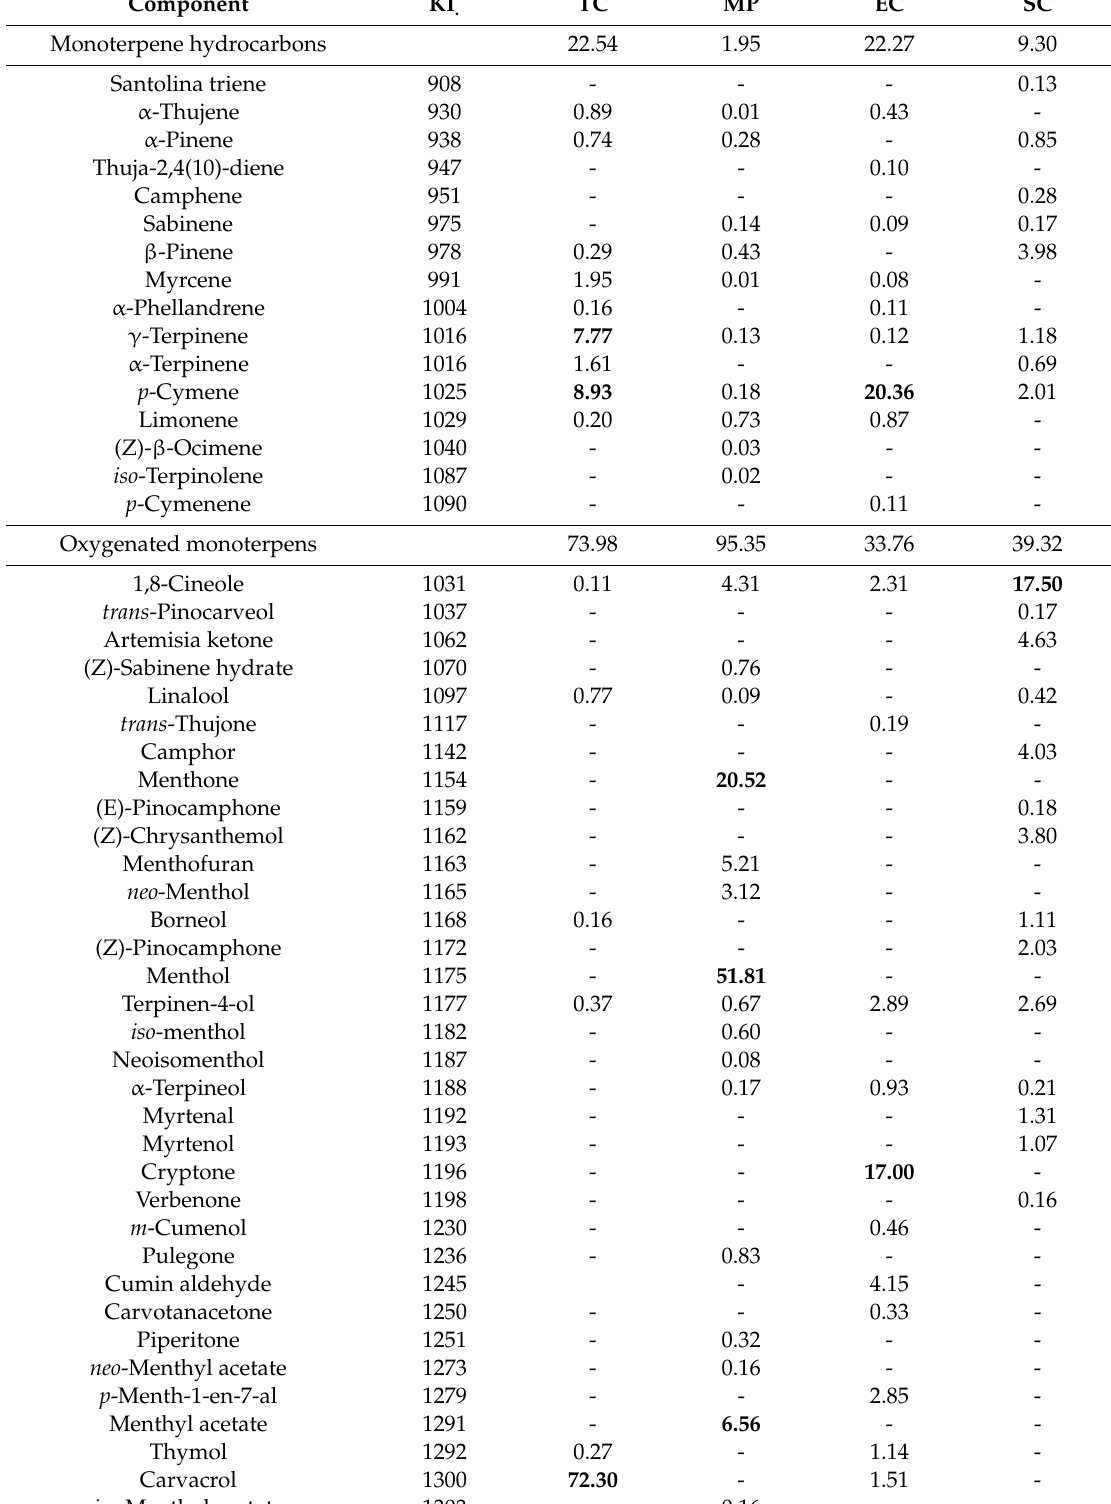
Table 3. Chemical composition of Thymbra capitata (TC), Mentha piperita (MP), Eucalyptus camaldulensis (EC), and Santolina chamaecyparissus (SC)